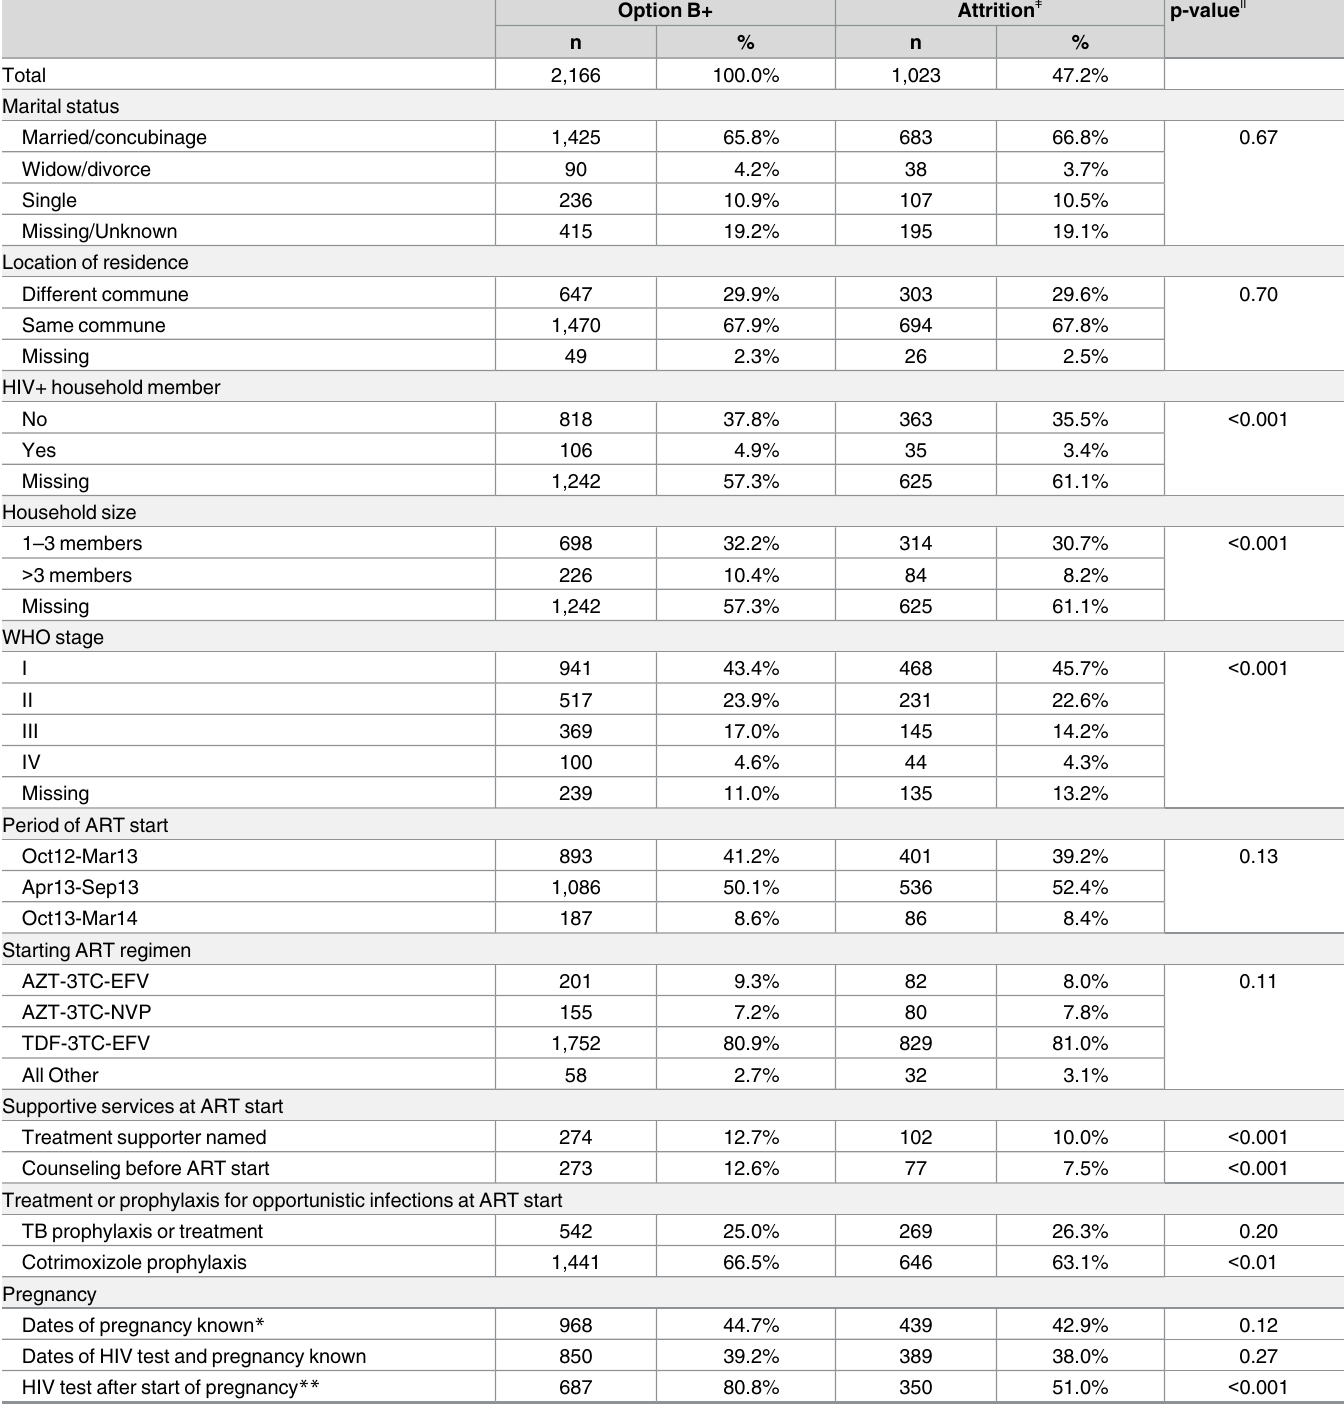
Table 1. Characteristics of Option B+ patients (Categorical